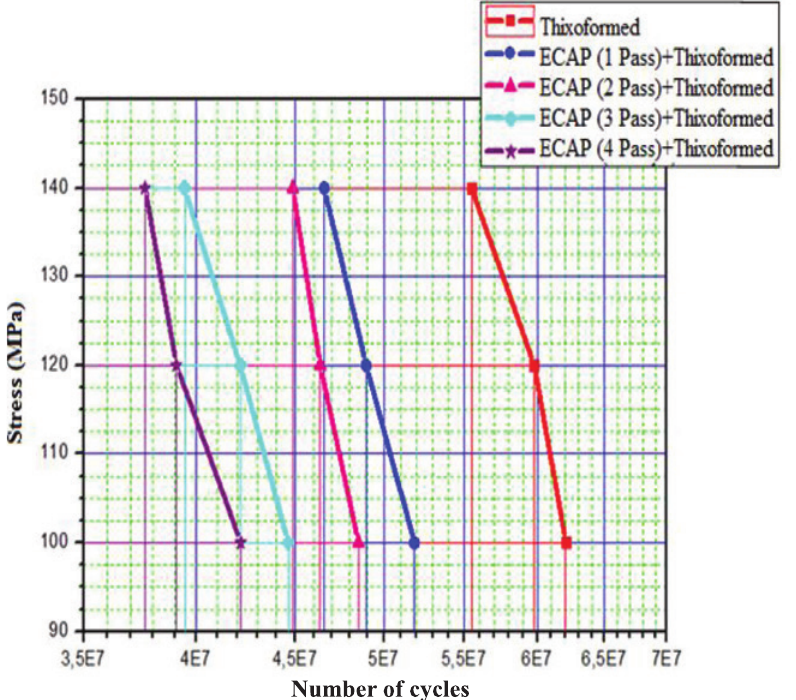
Fig. 7: Comparative S-N curve of Thixoformed, ECAP 1 Pass + Thixoformed, ECAP 2 Pass + Thixoformed, ECAP 3 Pass + Thixoformed,